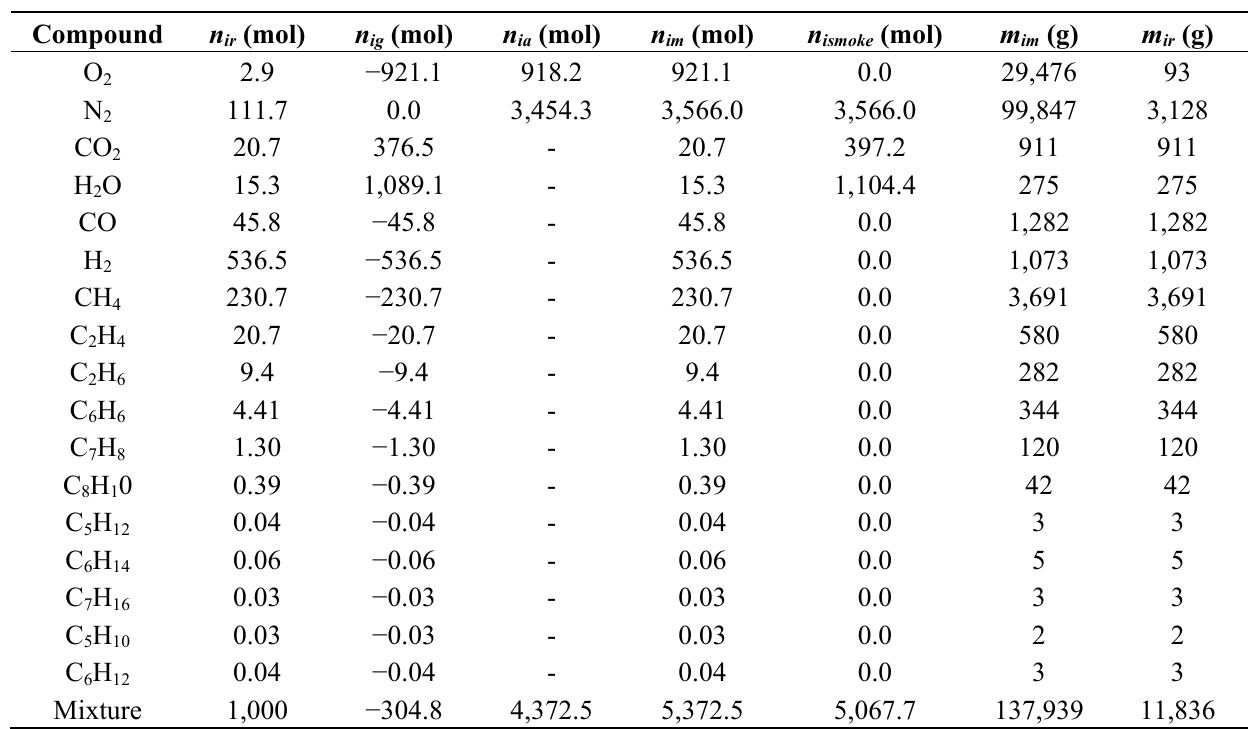
Table 7. Characterization of stoichiometric mixture (molar fraction: x molar mass: M = 25.7 g mol − 1 ) m